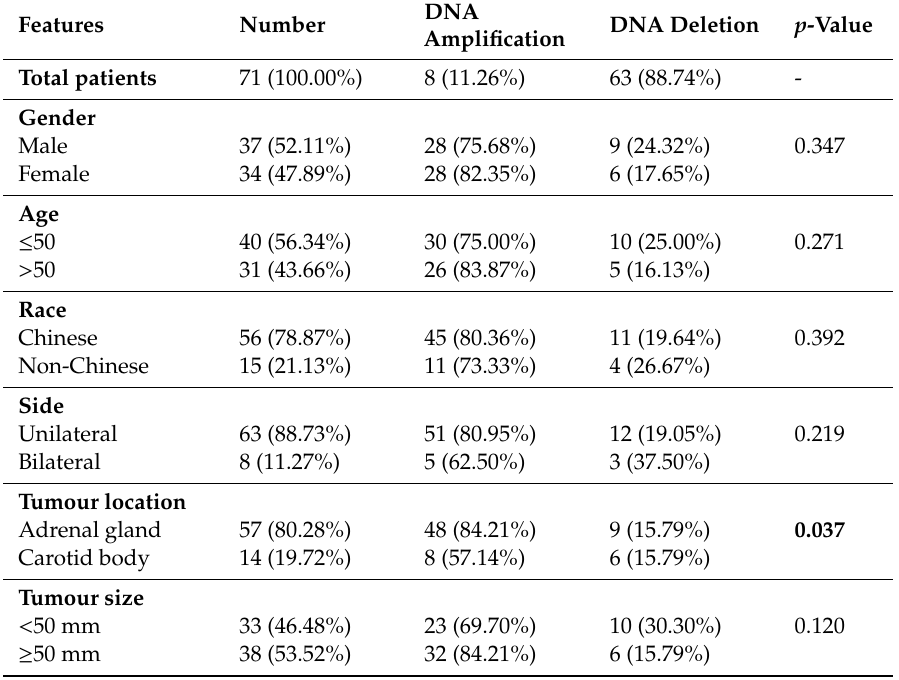
Figure 3. EPAS1 DNA number and mRNA expression profile in patients with phaeochromocytomas / paragangliomas. ( A ) Patients with phaeochromocytoma / paraganglioma exhibited significant EPAS1 DNA amplification in comparison to that of non-neoplastic tissues ( p < 0.01). ( B ) Similarly, patients with phaeochromocytomas / paragangliomas exhibited significant overexpression of EPAS1 mRNA in comparison to that of non-neoplastic tissues ( p = 0.002). Table 3. Correlation of EPAS1 DNA number changes with clinicopathological features of patients with pheochromocytoma and